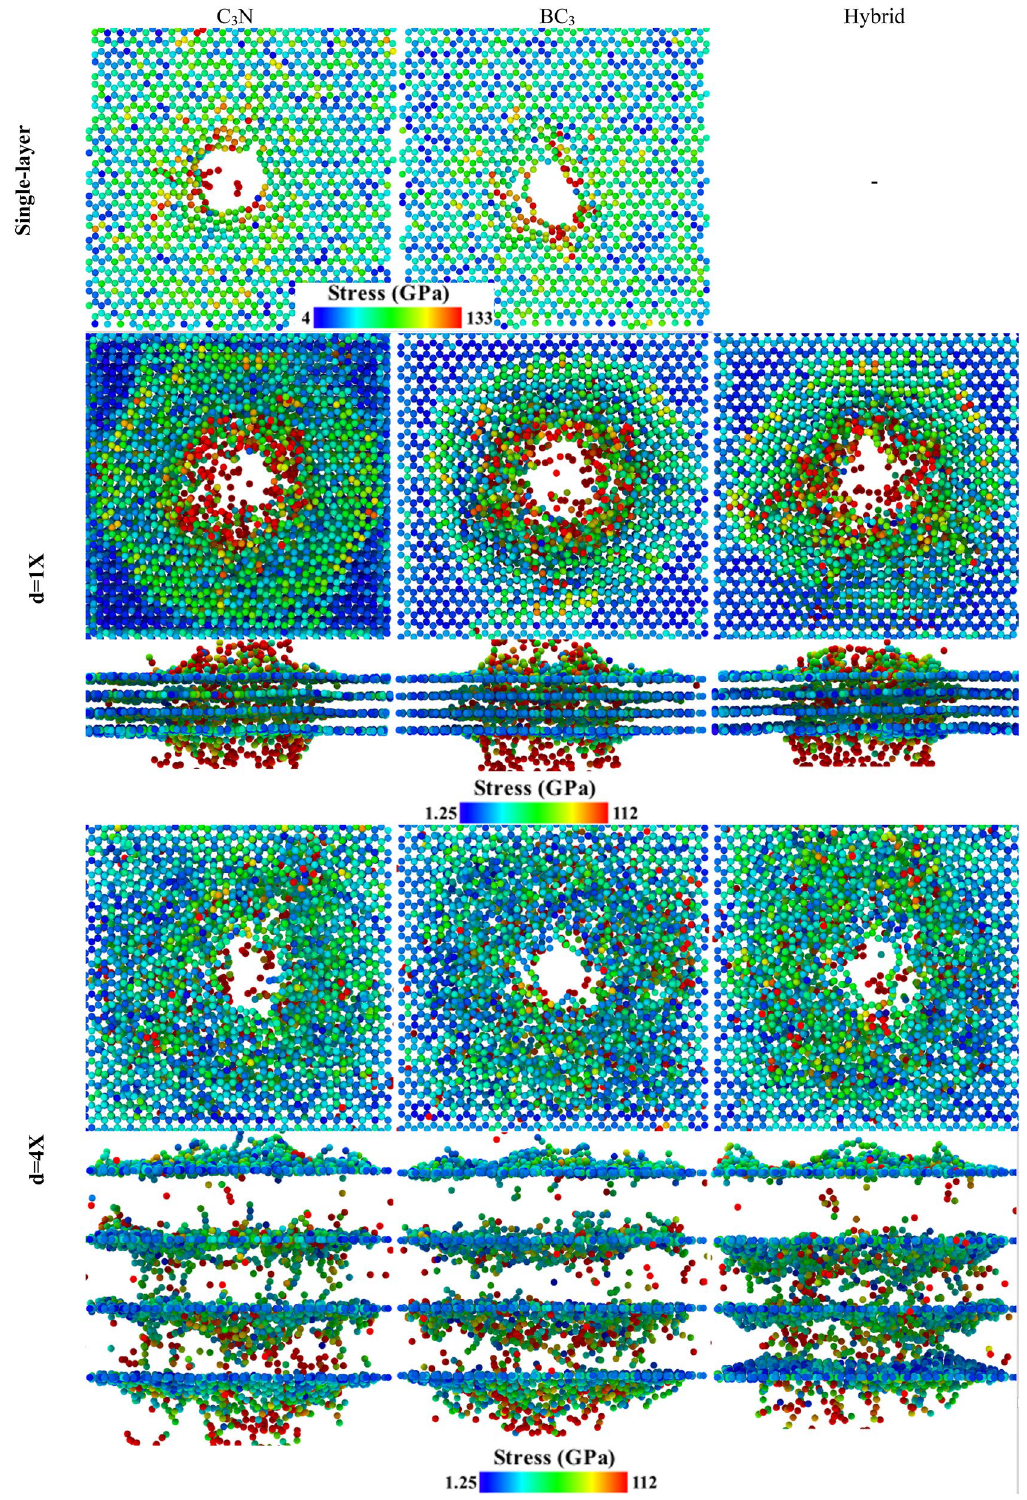
Figure 7. Von Mises stress distribution on a single layer and four-layer stacks of the C 3 N, BC 3, and C 3 N-BC 3 hybrid nanosheets after the C 60 impact with V 0 = 64.27 km/s for different layer spacing including X = 0.34 and 4X = 1.36